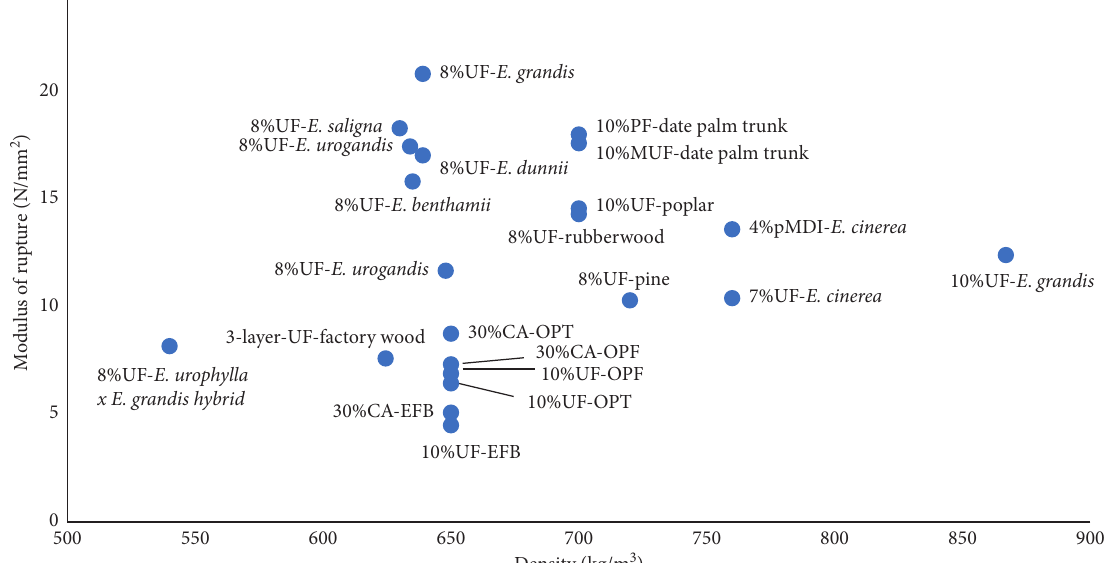
Figure 6: Modulus of rupture- (MOR-)density chart for particleboard made with Eucalyptus spp. and other wood species [35, 38–46]. ∗ Note: UF: urea-formaldehyde; PF: phenol-formaldehyde; MUF: melamine-urea-formaldehyde; pMDI: polymeric 4,4-diphenylmethane diisocyanate; CA: citric acid; OPT: oil palm trunk; OPF: oil palm frond; EFB: empty fruit